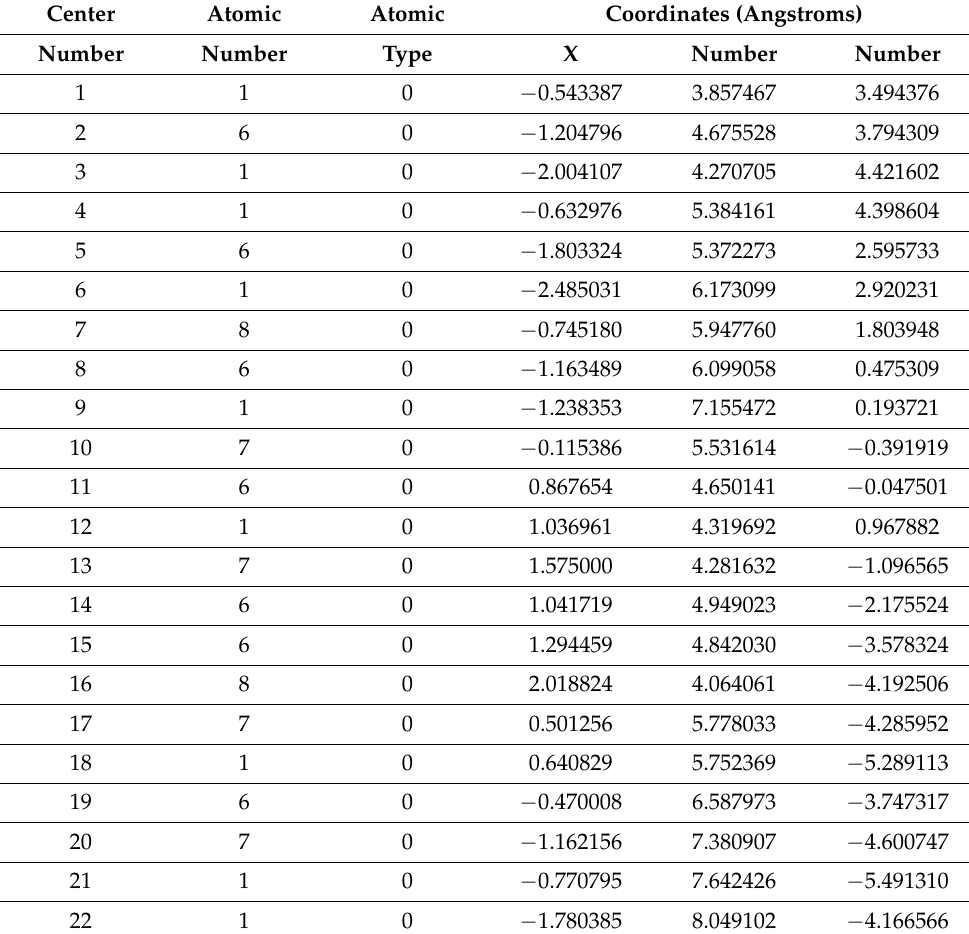
Table A9. Complex MgI 3 LiII 2 with nucleotide triplet